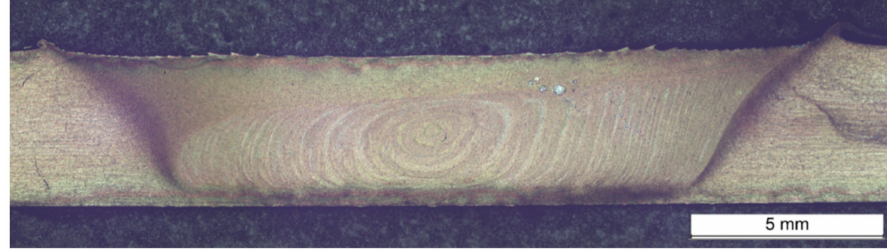
Figure 16. Cross section tool 2-20-8 with 0.9 mm